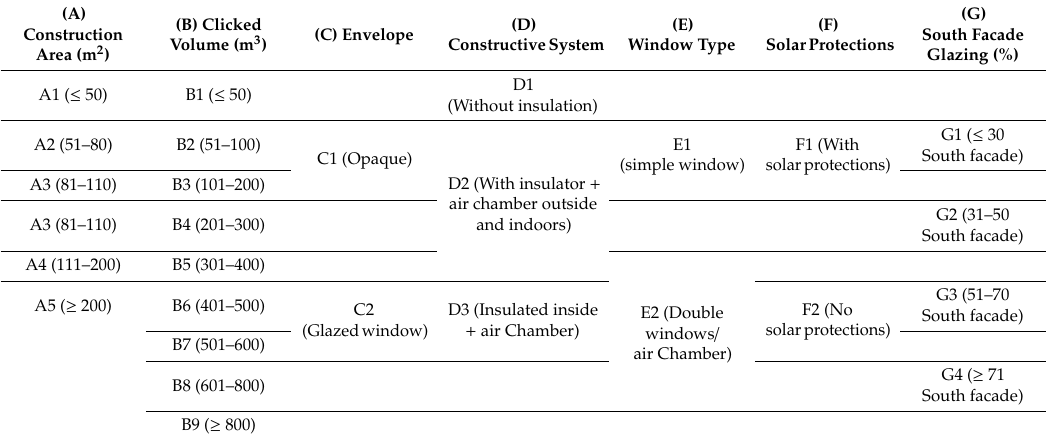
Table 5. Classification categories to identify the type of envelope of a building.